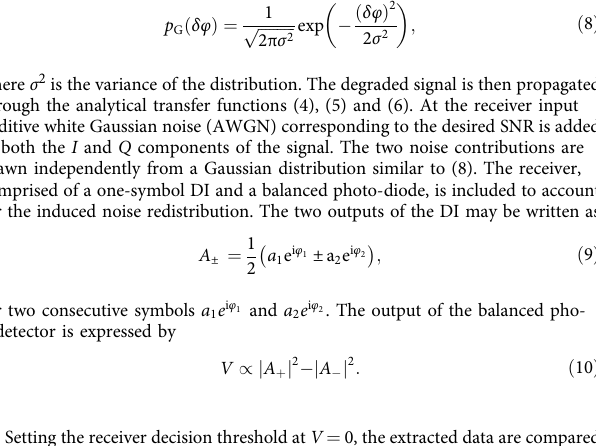
phase noise around Φ = 0. To identify the operating range with positive bene fi t from the regenerator, we sweep both the SNR and the phase noise per stage, σ ϕ = σ 1 ϕ = σ 2 ϕ , in the simulation to produce the colour map shown in Fig. 8c. The colours represent the regeneration performance, which is quanti fi ed by Δ Q = Q REG − Q B2B. The area within the black dashed contour lines is the parameter space for which the regenerator improves the Q factor. The white contour lines show the best achievable BER perfor- mance for different noise levels with associated values N indi- − N cating a BER of 10 . The best BER inside the black contour line “ 0 ” is obtained using the regenerator, and the best BER outside the black line “ 0 ” is obtained without the regenerator. The white contour lines bend down at the crossing points with the black contour line “ 0 ” , which indicates that within the black contour line best achievable BER is improved by using the regenerator.